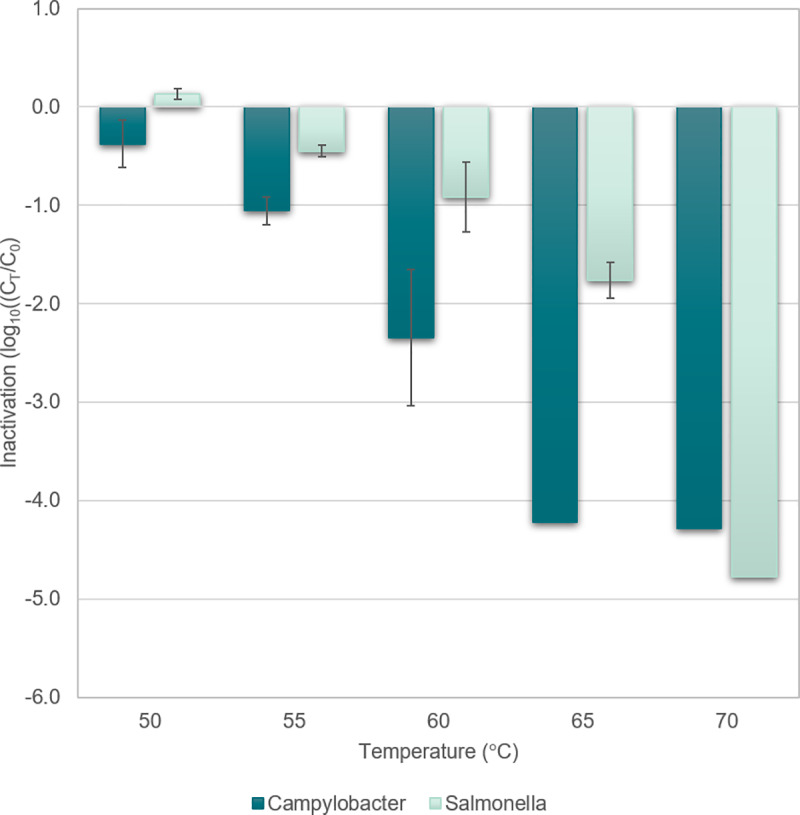
Inactivation of Campylobacter and
Salmonella in the core of the fillets having
reached different core temperatures.The inactivation was calculated as the ratio of viable organisms
after the core reached a certain temperature (CT) and
before cooking (Co). Mean and standard error for log transformed
values are shown. Columns without error bars indicate numbers below
the detection limit.